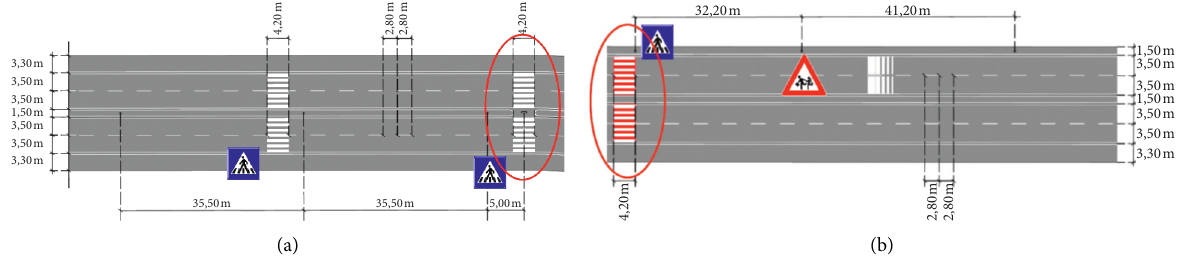
Figure 2: Layouts of white zebra crossing (a) and red and white zebra crossing